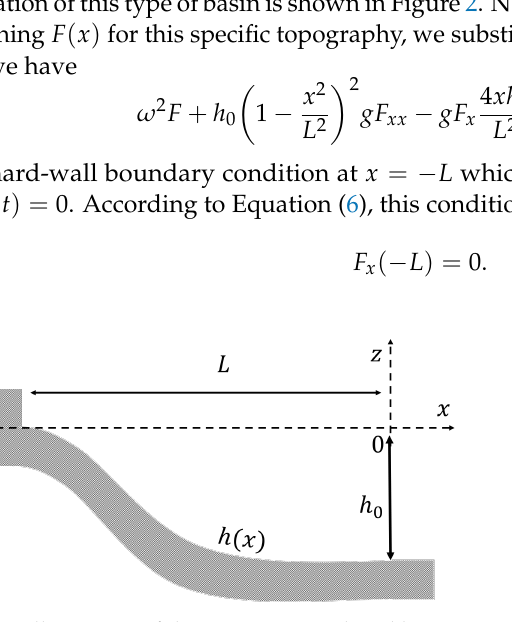
Figure 2. Illustration of the quartic semi-closed